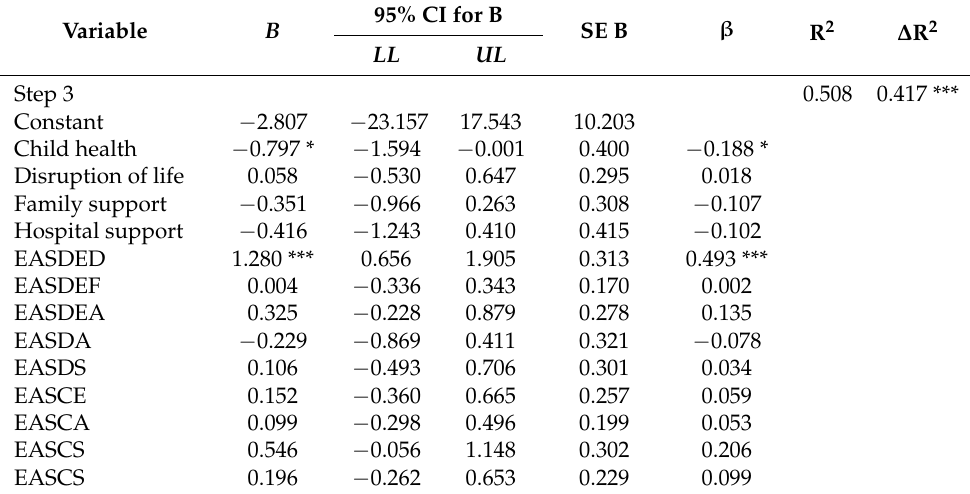
Table 7. Stress predictors in the group of parents of older